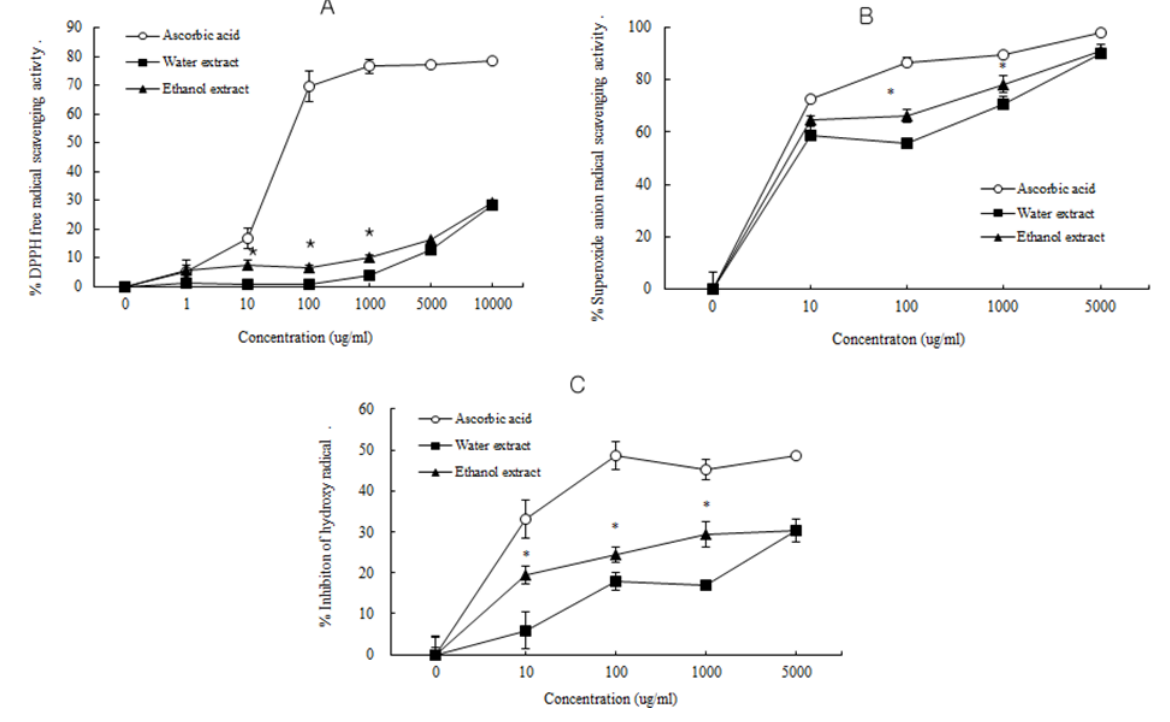
Figure 1. The radical scavenging activity of water and ethanol extracts from Drynariae rhizoma . ( A ) Free radical scavenging activity; ( B ) Superoxide anion radical scavenging activity; ( C ) Hydroxyl radical scavenging